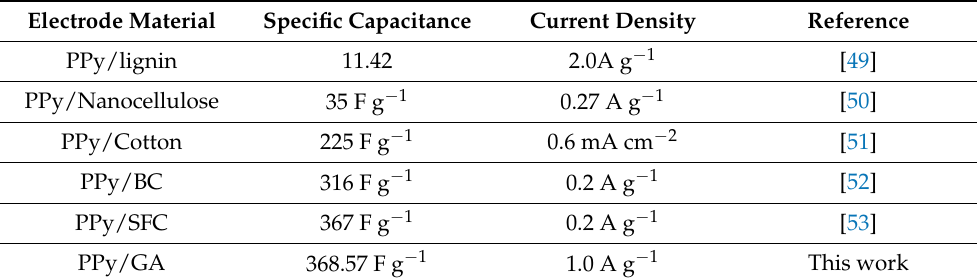
Table 4. Comparison of specific capacitance of PPy/biodegradable polymers-based electrodes. Electrode